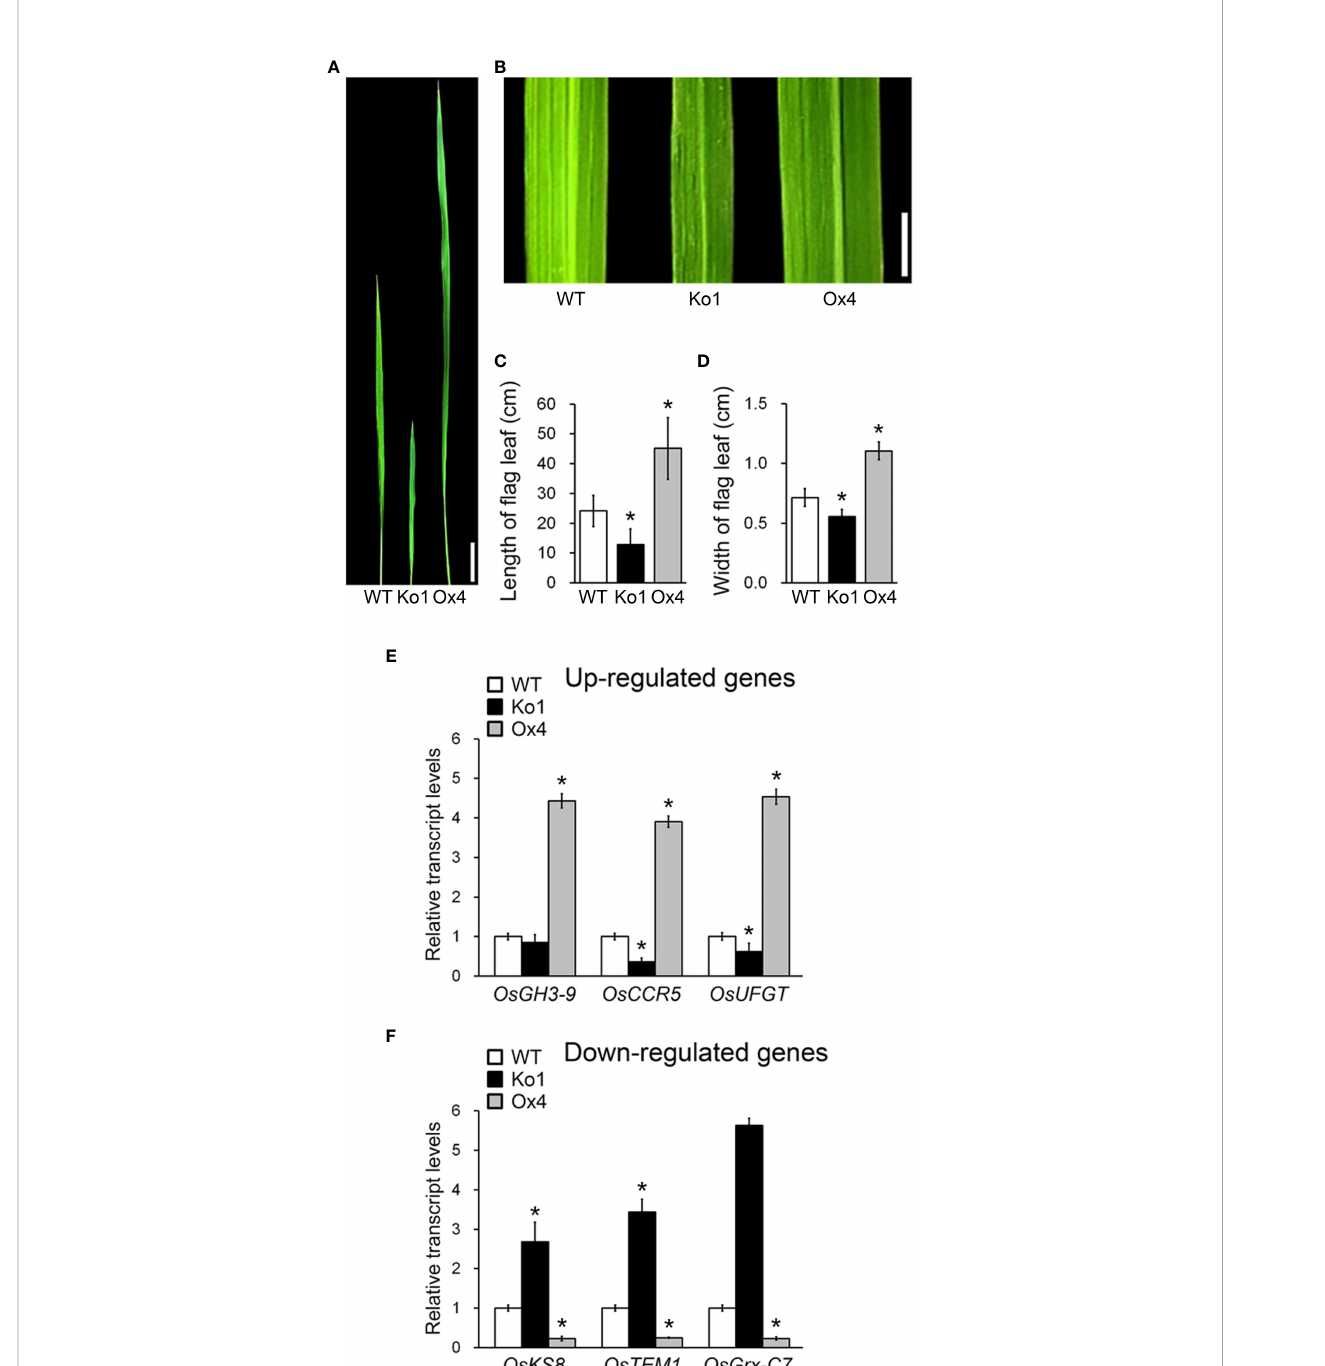
FIGURE 5 Analysis of fl ag leaf morphology and plant development related transcript level in osgasd knockout mutant and OsGASD -overexpressing transgenic plants. (A, B) Morphology of fl ag leaf in wild-type (WT), osgasd knockout mutant (Ko) and OsGASD -overexpressing (Ox) plants grown in the fi eld. Image show fl ag leaf (A) and fl ag leaf surface (B) . Scale bar = 1cm (A) and 0.5cm (B) . (C, D) Length © and width (D) of fl ag leaf in WT, osgasd Ko and OsGASD- Ox plants. Error bars indicate SD (n = 20). (E, F) Analysis of plant development related genes expression in WT, Ko and Ox plants. The transcripts were selected by transcriptome analysis in fl ag leaf of osgasd Ko, OsGASD- Ox and WT plants. RT-qPCR analysis shows up-regulated (E) and down-regulated (F) transcriptional expression levels. The gene name and accession liseted in Tables S2. Error bars indicate SD. OsActin1 (Os03g0718100) was used as an internal control and relative expression levels are shown in fold values. Asterisks indicate statistically signi fi cant differences between the corresponding samples and their control (p-value<0.1, Student ’ s